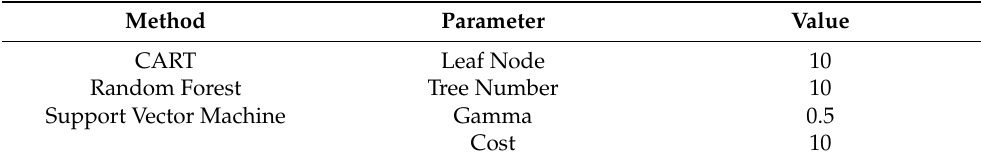
Table 1. Parameters of the classifiers.